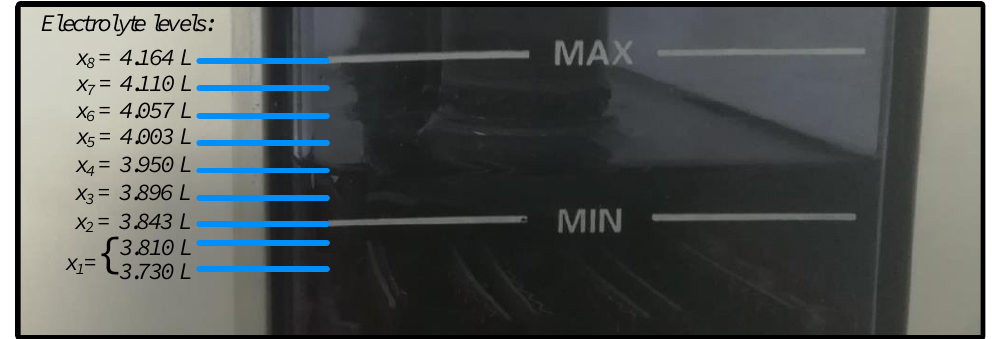
Figure 3. The eight electrolyte setting levels used to characterize R 0